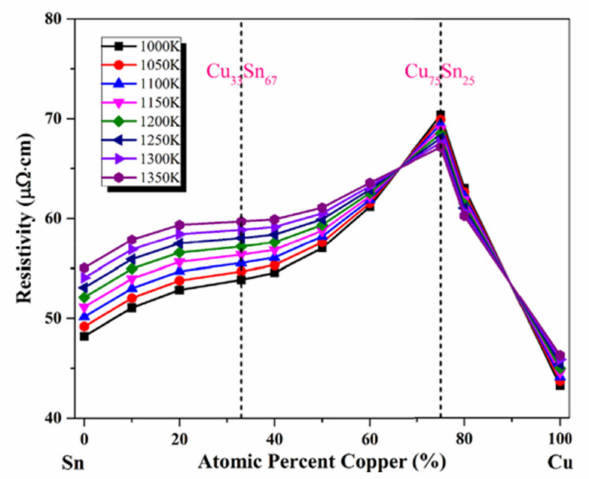
Figure 15. Composition dependent on resistivity for liquid Cu-Sn alloys